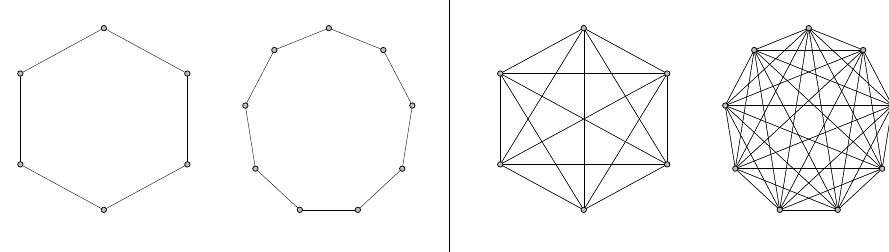
Figure 1. The ring network (left) and F.con network (right) are shown for the case there are two genes consisting of 6 and 9 CpG sites,